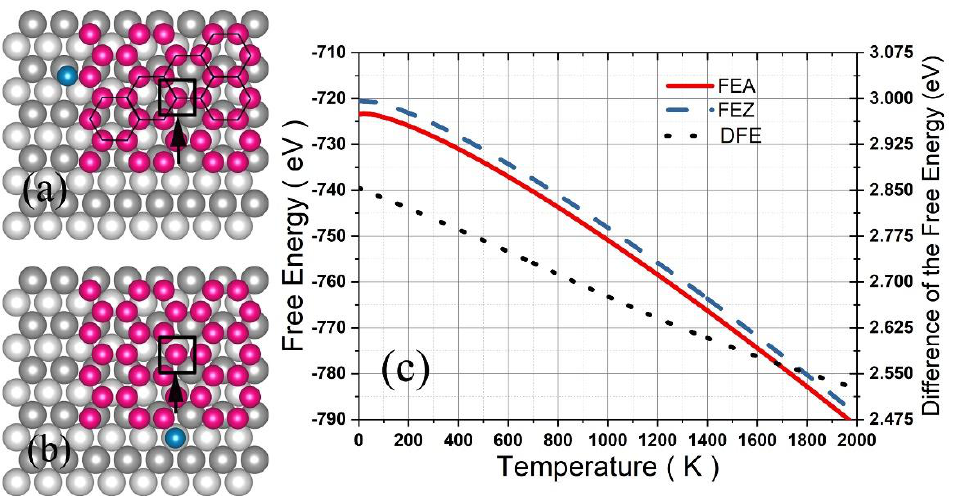
Figure 7. A silicene grain of four silicon hexagons on the Ag (110) surface with a deposited Si atom adhered to the zigzag ( a ) or armchair edge ( b ). The free energy for the zigzag adherence and armchair adherence and the difference are shown in ( c ).